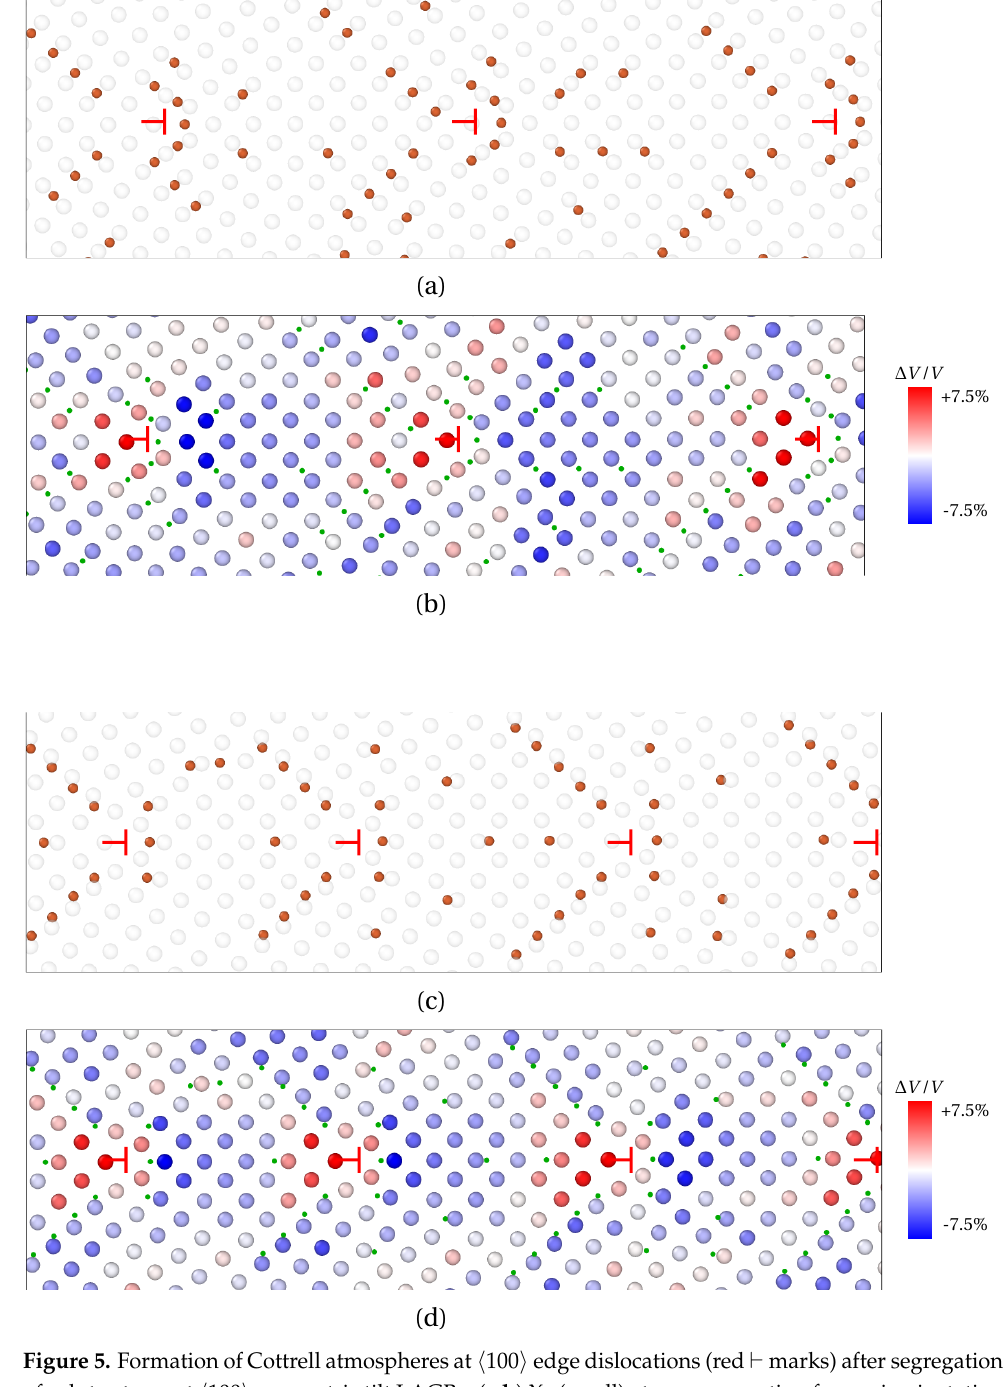
Figure 5. Formation of Cottrell atmospheres at (cid:104) 100 (cid:105) edge dislocations (red (cid:96) marks) after segregation of solute atoms at (cid:104) 100 (cid:105) symmetric tilt LAGBs. ( a , b ) X 1 (small) atoms segregation for a misorientation angle θ = 7.15 ◦ . ( c , d ) X 2 (larger) atoms for θ = 9.53 ◦ . ( a , c ) solute atoms distribution (orange) and Fe atoms (transparent). ( b , d ) Volume per atom variation ∆ V / V (Voronoi analysis). Red—dilatation, blue—compression. X atoms are spotted by green dots in ( b , d